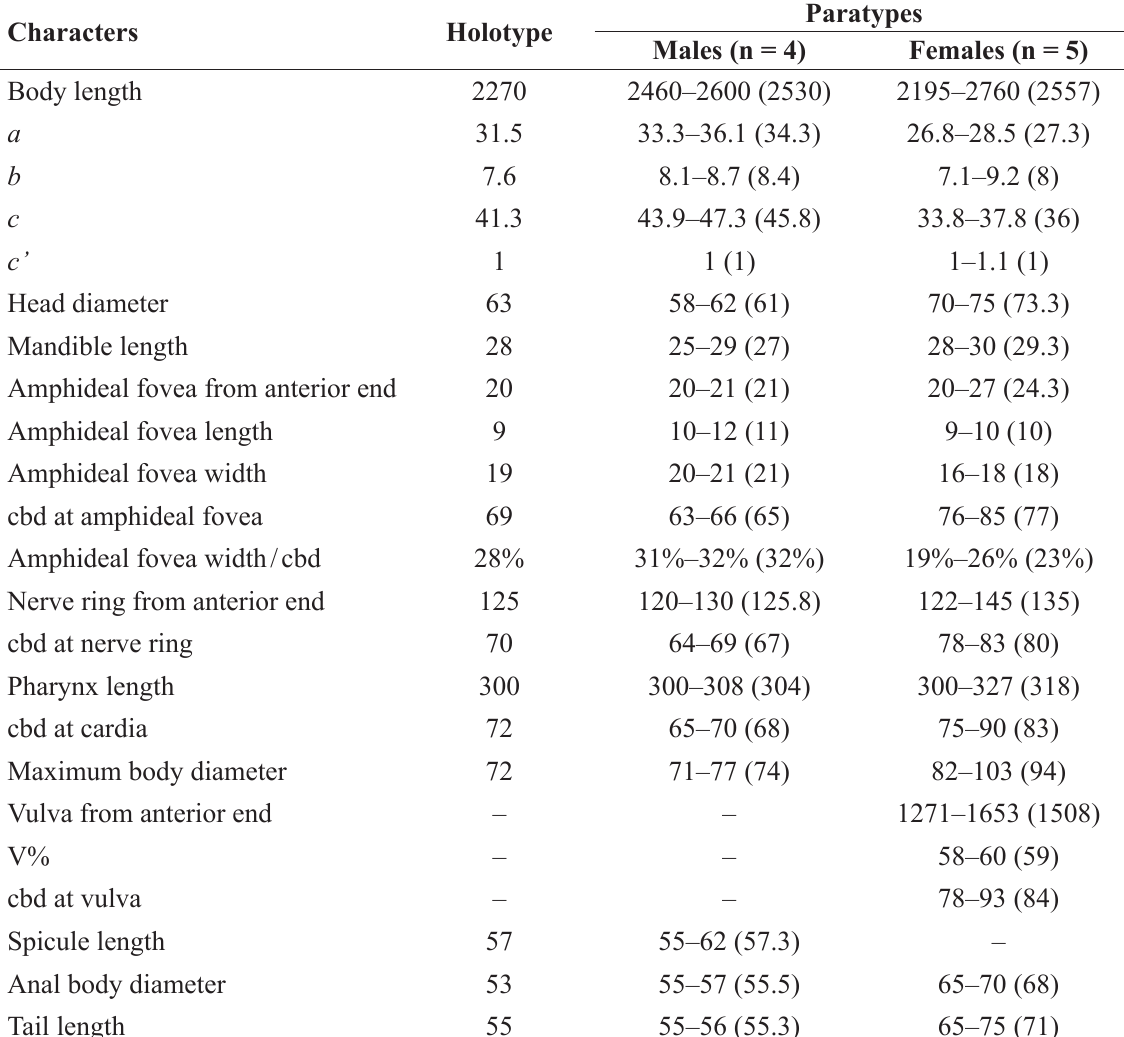
Table 2. Morphometrics (measurements in μm) of Synonchium caudatubatum sp. nov. Figures between brackets represent mean